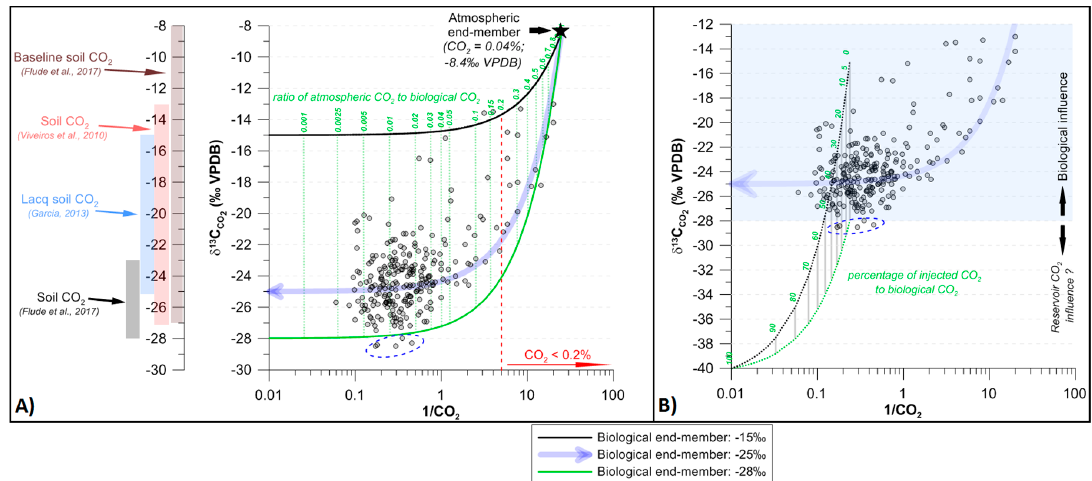
Figure 6. Carbon ‐ isotope ratios (  13 C CO2 ) as a function of the inverse of CO 2 concentration in soil gas Figure 6. Carbon-isotope ratios ( δ 13 C CO2 ) as a function of the inverse of CO 2 concentration in soil gas (semi ‐ logarithmic scale). A ) three atmospheric ‐ biological mixing lines are calculated, using 0.04% CO 2 (semi-logarithmic scale). ( A ) three atmospheric-biological mixing lines are calculated, using 0.04% CO 2 and − 8.4‰ Vienna Pee Dee Belemnite (VPDB) standard for the atmospheric end ‐ member, and 10% and − 8.4 ‰ Vienna Pee Dee Belemnite (VPDB) standard for the atmospheric end-member, and 10% CO 2 and − 15 to − 28‰ VPDB for the biological end ‐ member. Variation ranges of literature data are CO 2 and − 15 to − 28 ‰ VPDB for the biological end-member. Variation ranges of literature data are reported on the Y ‐ axis. B ) mixing curves between two biological end ‐ members ( − 15 and − 28‰) and reported on the Y-axis. ( B ) mixing curves between two biological end-members ( − 15 and − 28 ‰ ) and hypothetical deep CO 2 end ‐ member (taken at − 40‰). hypothetical deep CO 2 end-member (taken at − 40 ‰